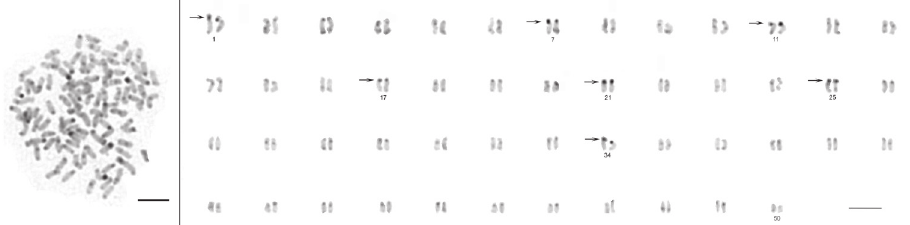
Figure 5. karyotype of C. carassius female arranged from C-banded chromosomes. Seven pairs of chro- mosomes show significant signals (black arrows). Bar = 10